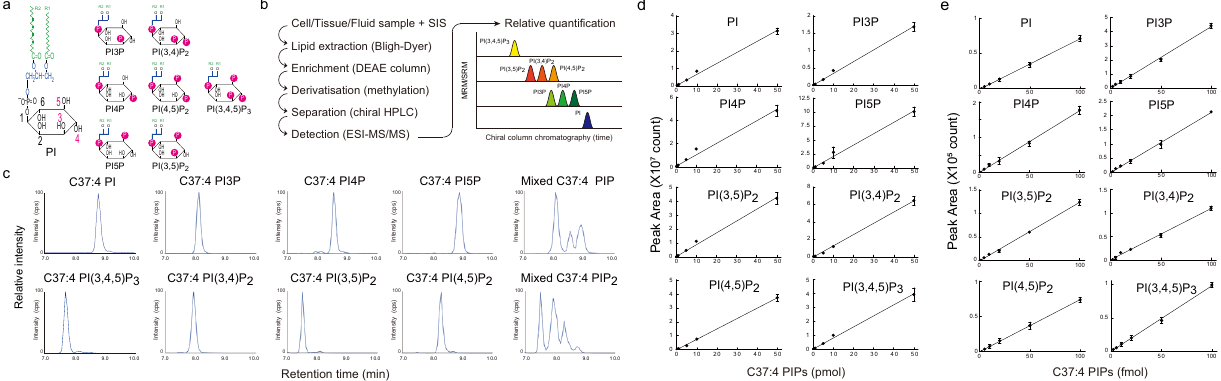
Fig. 1 Phosphoinositide regioisomer measurement by PRMC-MS. a Schematic structures of the eight phosphoinositide classes. Note that phosphatidylinositol mono- and bisphosphate (PIP and PIP 2 ) classes each contain three regioisomers. b Scheme depicting the general work fl ow of PRMC- MS. SIS, surrogate internal standard lipids. c Mass spectra from PRMC-MS analyses of C37:4 (1-heptadecanoyl-2-eicosatetraenoyl) standard chemicals representing each of the eight phosphoinositide classes. Mixed, a mixture of PIP or PIP 2 regioisomers. d , e Linear regression analyses of peak area vs pmol ( d ) and fmol ( e ) concentrations of the indicated phosphoinositides. Amounts of standard phosphoinositides analyzed were 0.002, 0.005, 0.01, 0.02, 0.05, 0.1, 0.2, 0.5, 1, 5, 10, 50 pmol in d and 2, 5, 10, 20, 50, 100 fmol in e (see also Supplementary Table 1). The C37:4 (1-heptadecanoyl-2-eicosatetraenoyl) molecular species of each phosphoinositide class was used. Data were the mean ± SD ( n = 4 technical replicates). Source data are provided as a Source Data fi